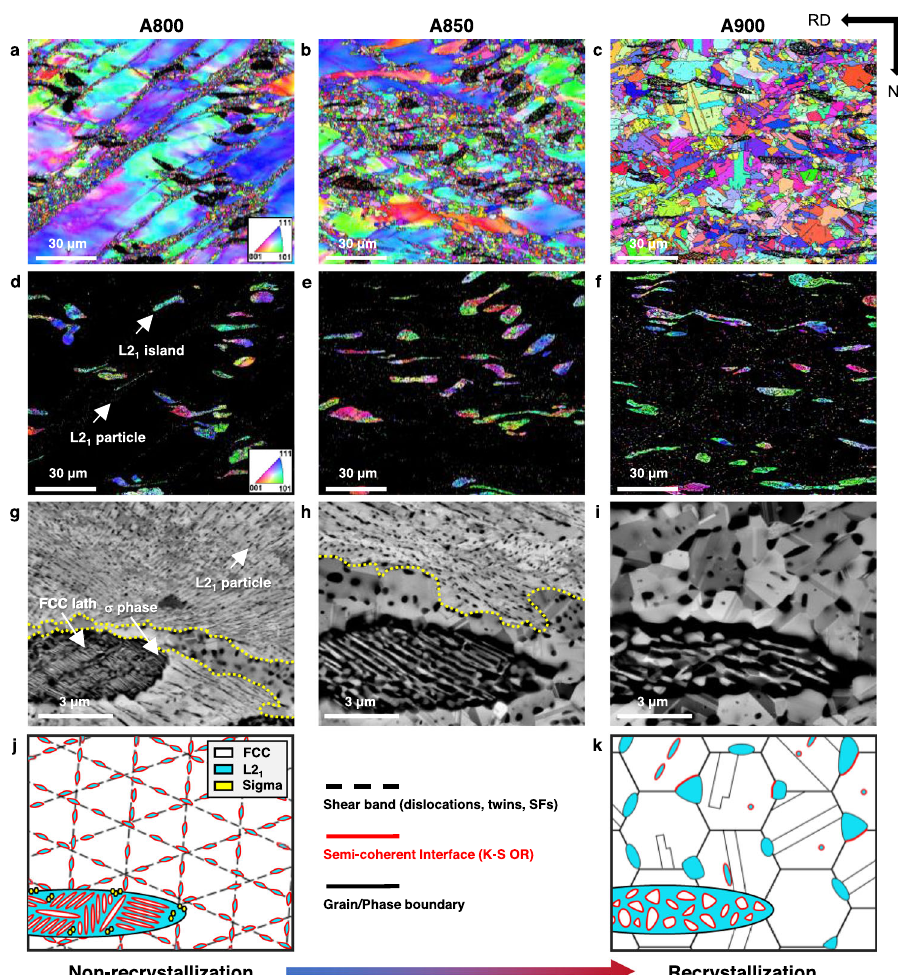
Fig. 2 Microstructural evolutions with increased heat-treatment temperature. a – c Electron backscatter diffraction (EBSD) maps of face-centered-cubic (FCC), d – f EBSD maps of L2 1 phases, g – i electron-channeling contrast imaging (ECCI) micrographs for Al 0.2 CoNiV alloys annealed at 800, 850, and 900 °C for 1 h. Yellow-dotted lines indicate the boundaries between the recrystallized region and the non-recrystallized region. j , k Schematics showing the microstructural evolutions from non-recrystallized state to recrystallized